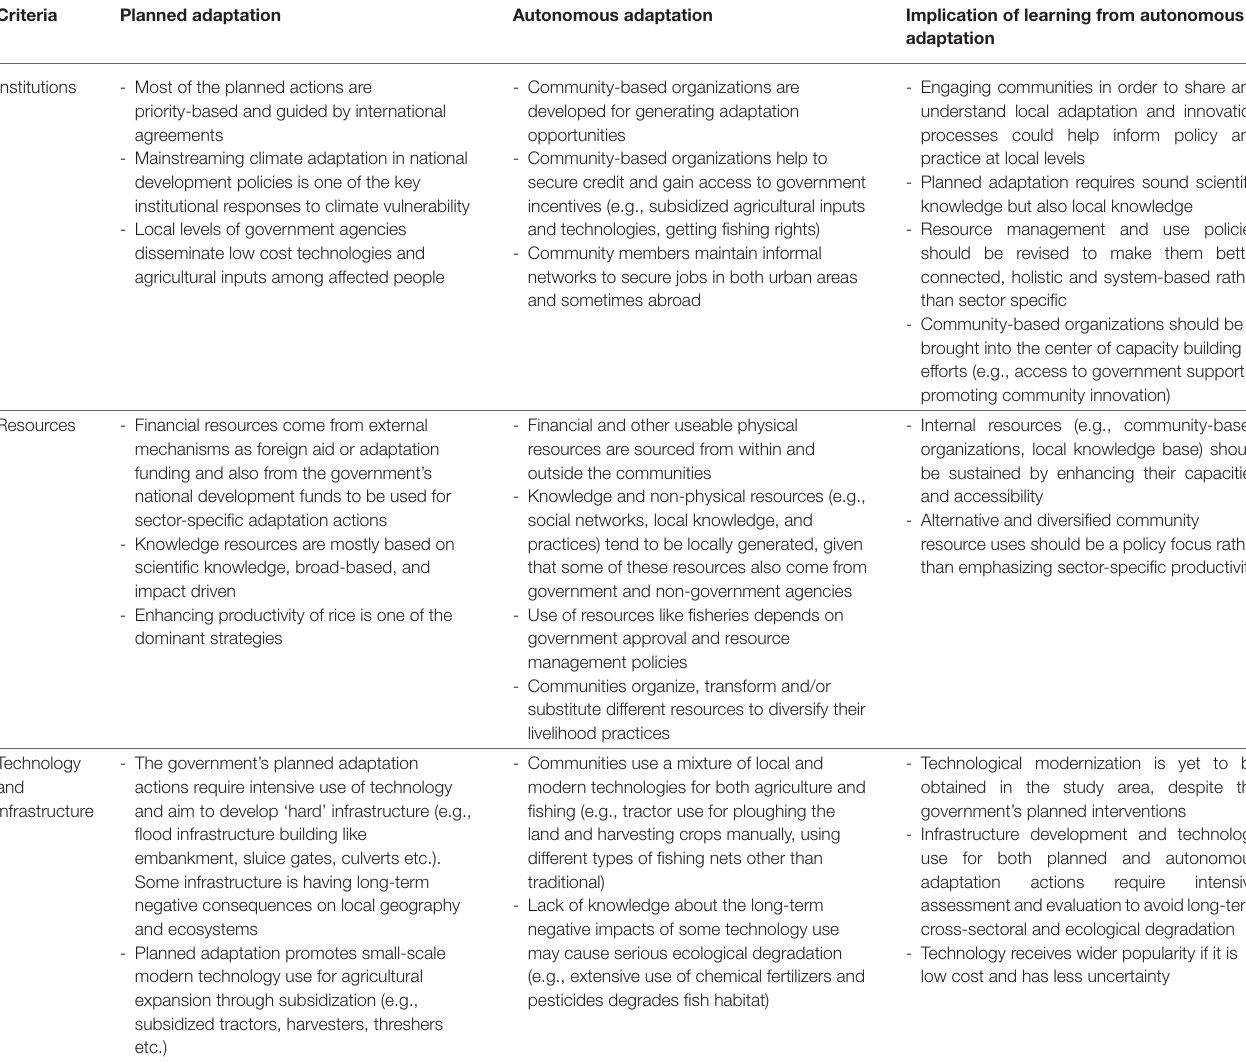
TABLE 1 | Learning from autonomous adaptation to inform planned adaptation in the northeastern floodplain of Bangladesh.